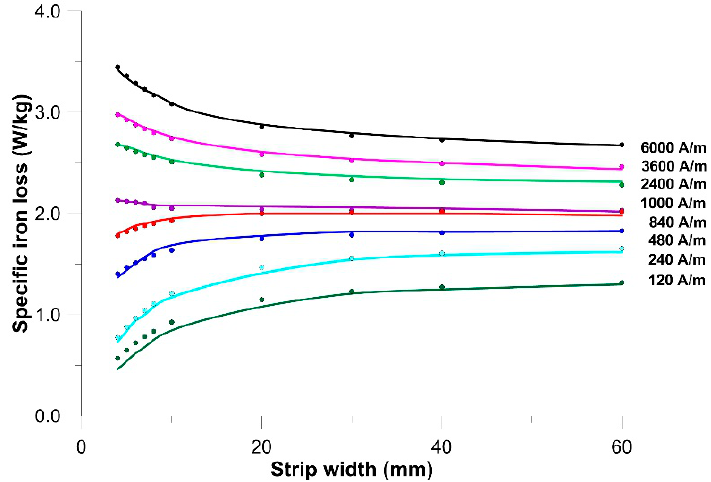
Figure 8. Comparison of the average specific iron loss, at 50 Hz. The measurement (lines) and simulation (points) results. The strips cut at an angle of 0 degrees. Magnetic field strength changed in the range from 120 A/m to 6000 A/m.